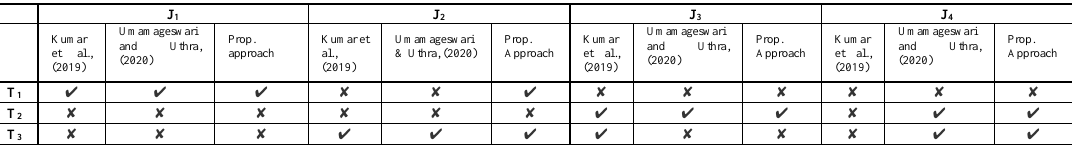
Table 8. Table of comparison for allocation for example 2.